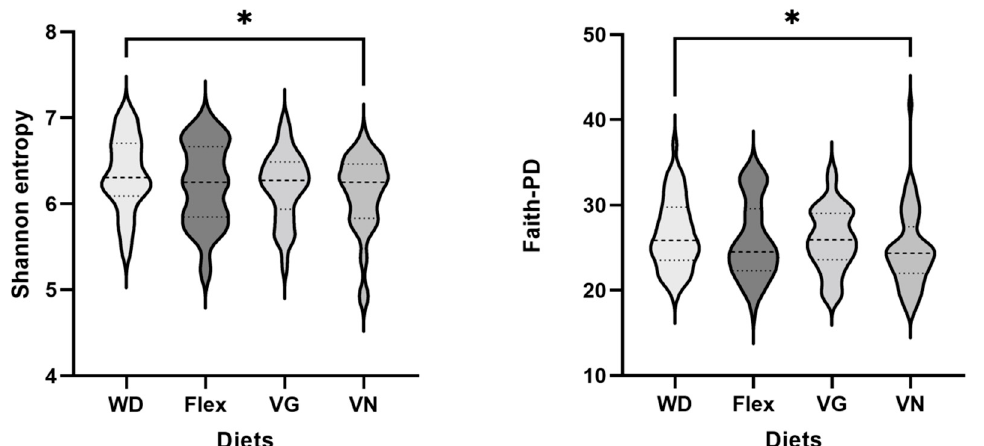
Figure 2. Violin plots showing distribution of alpha diversity metrics Shannon entropy and Faith-PD for each diet. Significant differences only detected for pairwise comparison (unpaired t -test) of WD